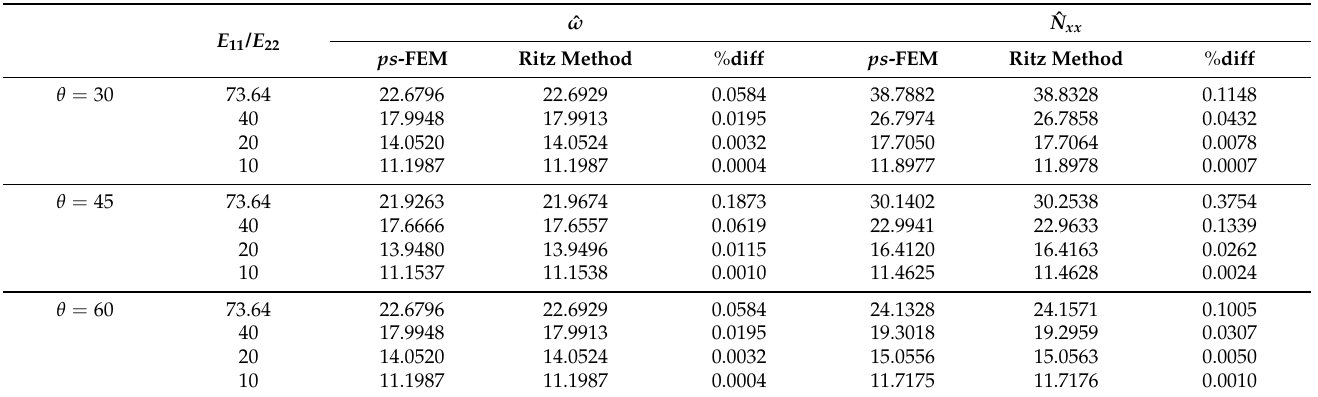
Table 7. Nondimensional frequencies ˆ ω and buckling load ˆ N xx for SSSS plates with different degrees of